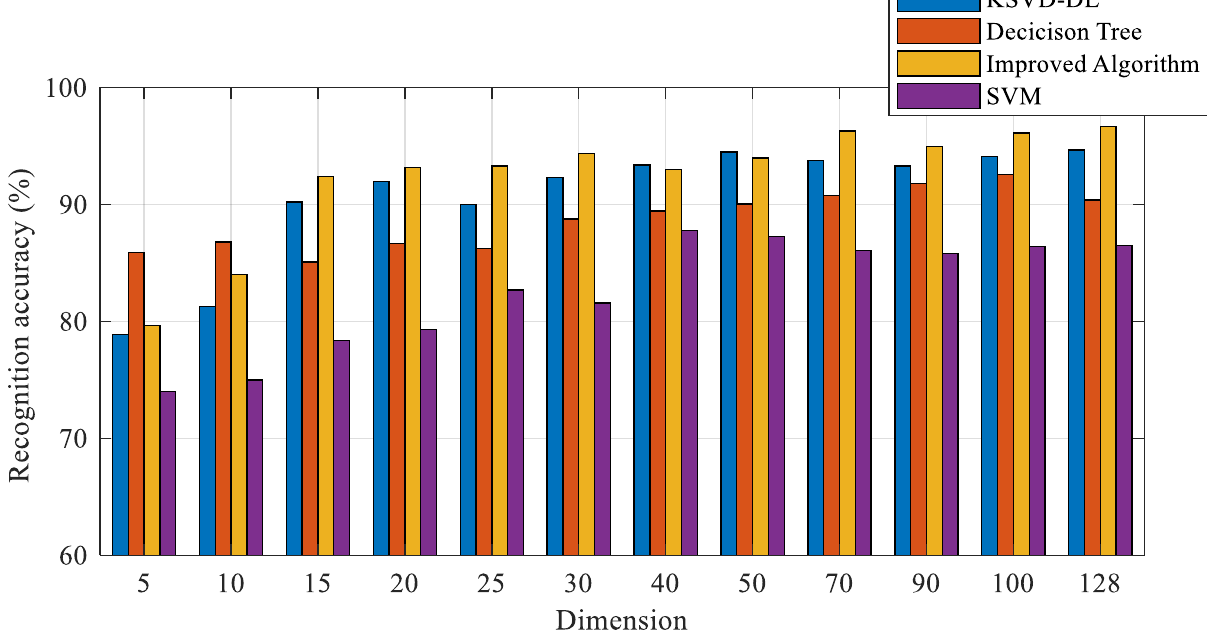
Figure 13. The recognition accuracy of the traditional algorithm and improved algorithm.